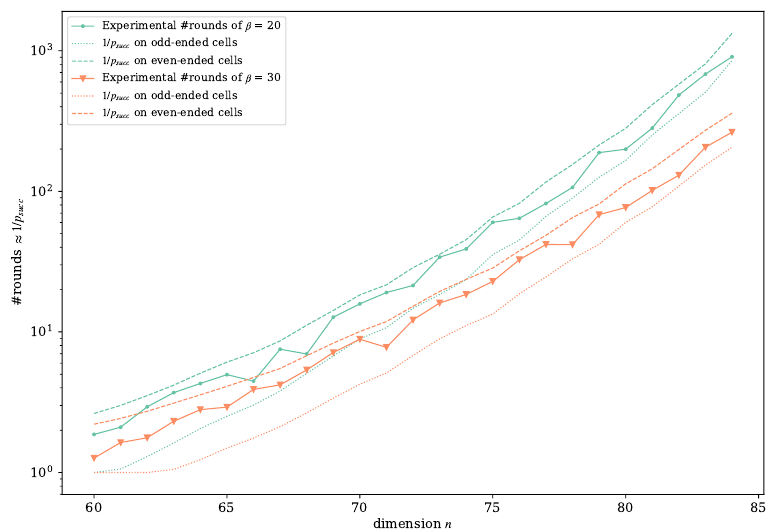
Figure 8. The difference of p succ estimated with odd-ended cells and even-ended